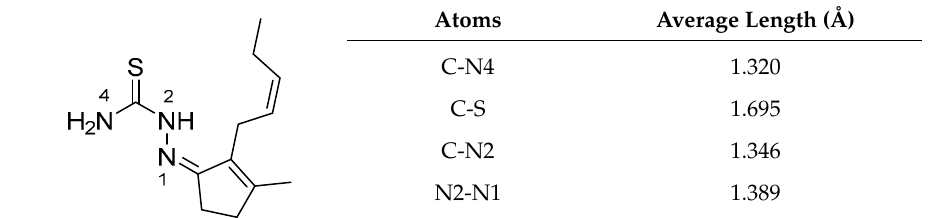
Table 2. Average bond lengths in the thiosemicarbazone moiety of the three molecules.